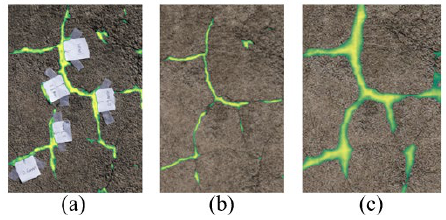
Figure 7. Marked cracks (0.6mm-1.0mm): (a) 1m with label, (b) 1m without label, and (c) 3m without label.